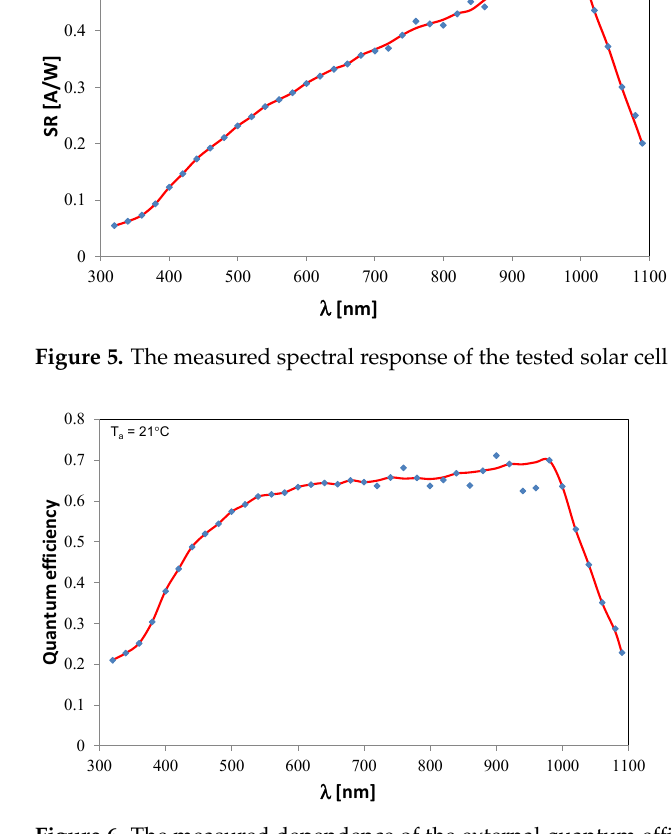
Table 2. The values of the normalized power produced by the solar cell at irradiation from the tested light sources and values of parameter a . Lighting Source Bulb